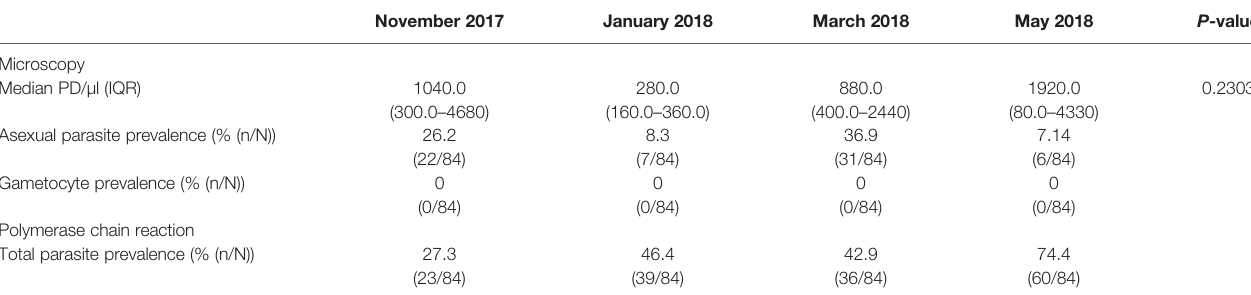
TABLE 2 | P . falciparum parasite density and prevalence by microscopy and polymerase chain